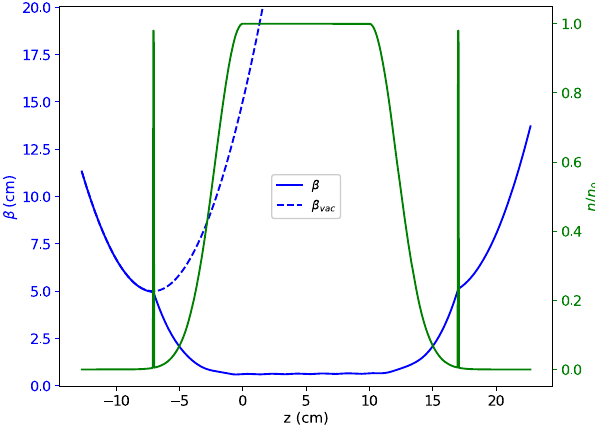
FIG. 1. Evolution of the beta function of a 10 GeV electron beam through a plasma wakefield accelerator (PWFA) with density ramps of half-width 2.54 cm and peak density n ¼ 3 × 10 16 cm − 3 . A thin plasma lens is located at the entrance 0 and exit of the PWFA to match the incoming beam and mitigate its final divergence, respectively. The plasma density profile n p is given by the solid green line. The electron beam ’ s beta function β is given by the solid blue line. The beta function corresponding to vacuum propagation is given by the dashed blue